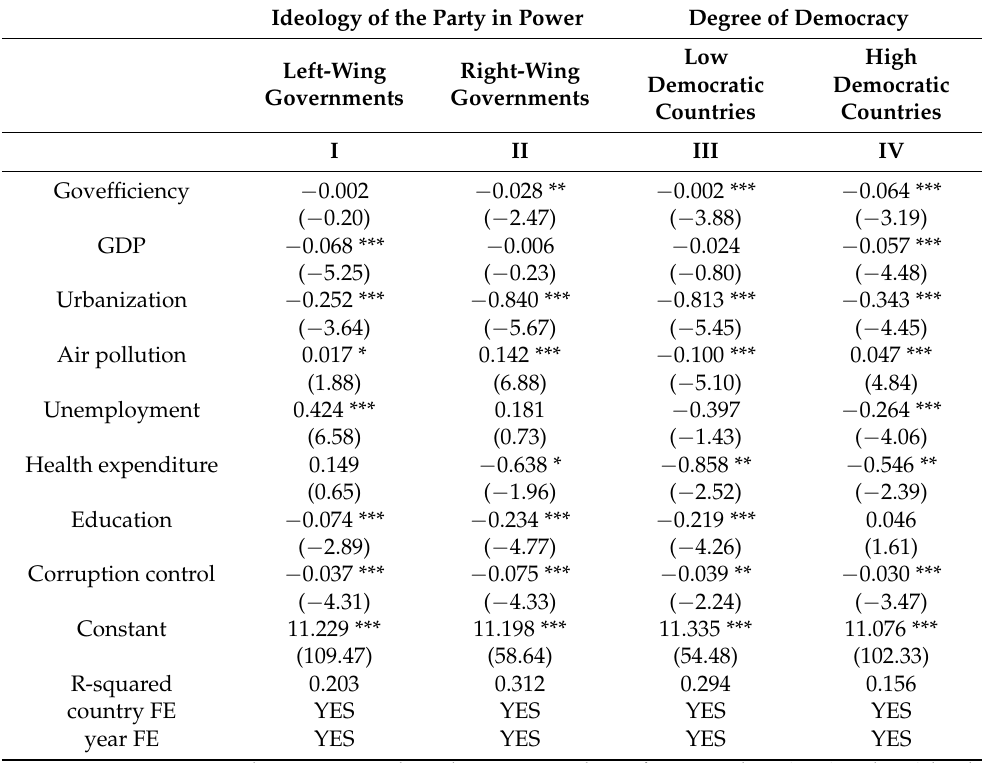
Table 6. Moderating effect